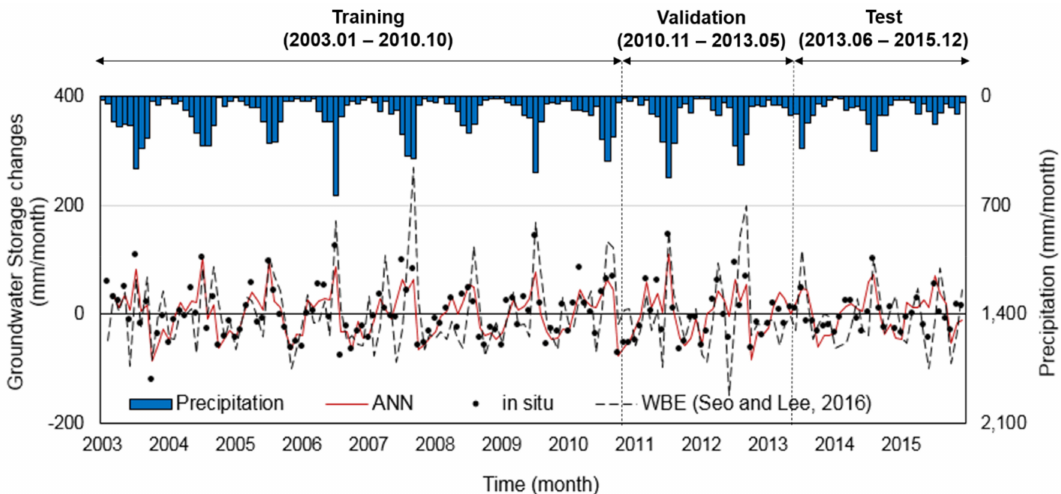
Figure 4. Time series of ∆ GWS (ANN-predicted, in situ, and water balance equation (WBE)-estimated) with monthly precipitation.